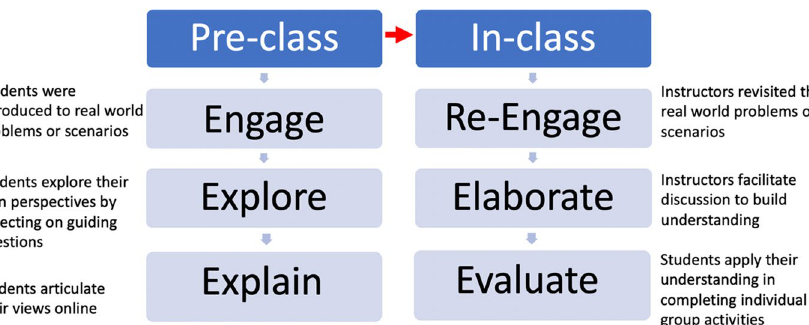
Fig. 2 5E framework used to design the two conventional flipped